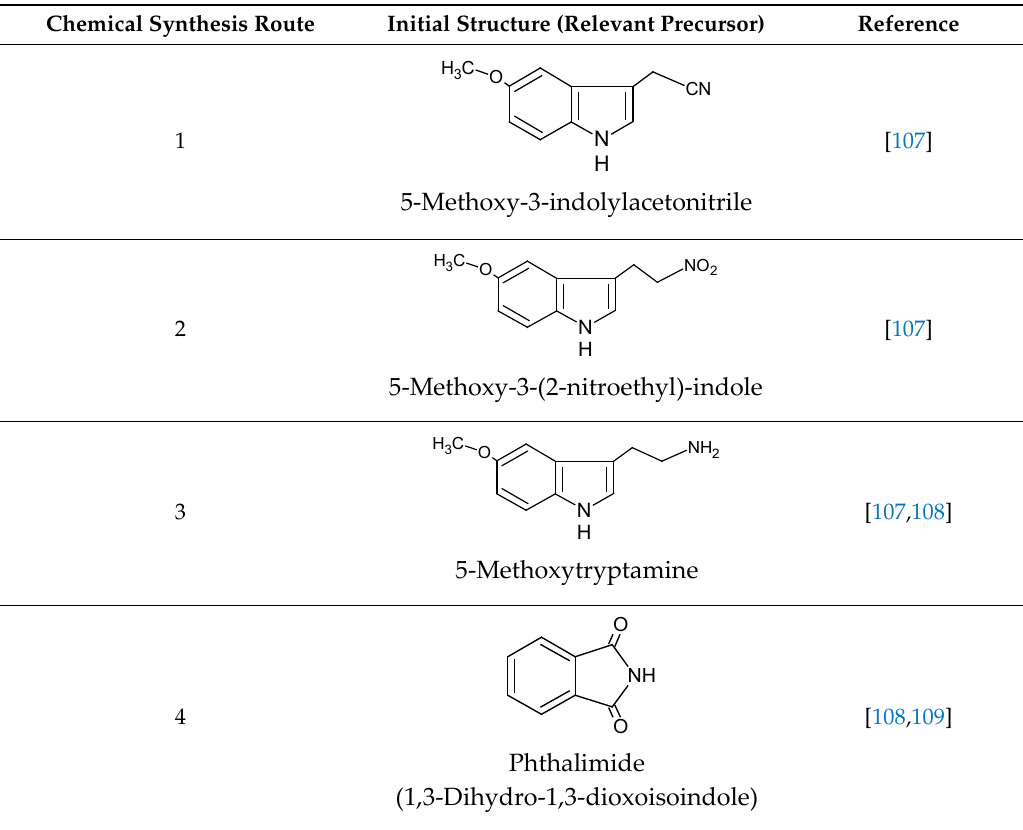
Table 4. Common contaminants in synthetic melatonin